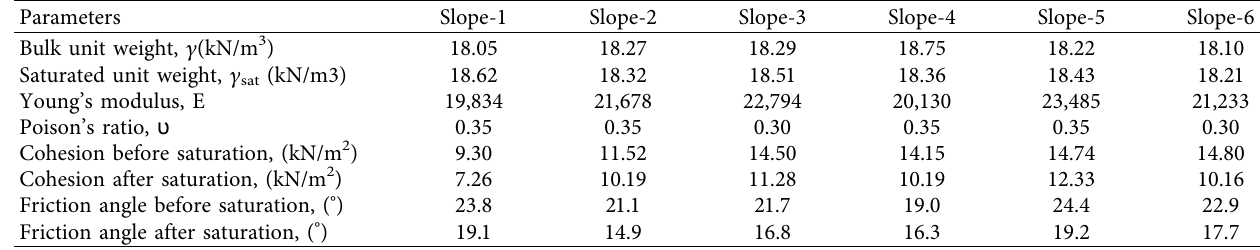
Figure 2: Test pit for a sampling of the soil. Table 1: Input parameters for LEM and